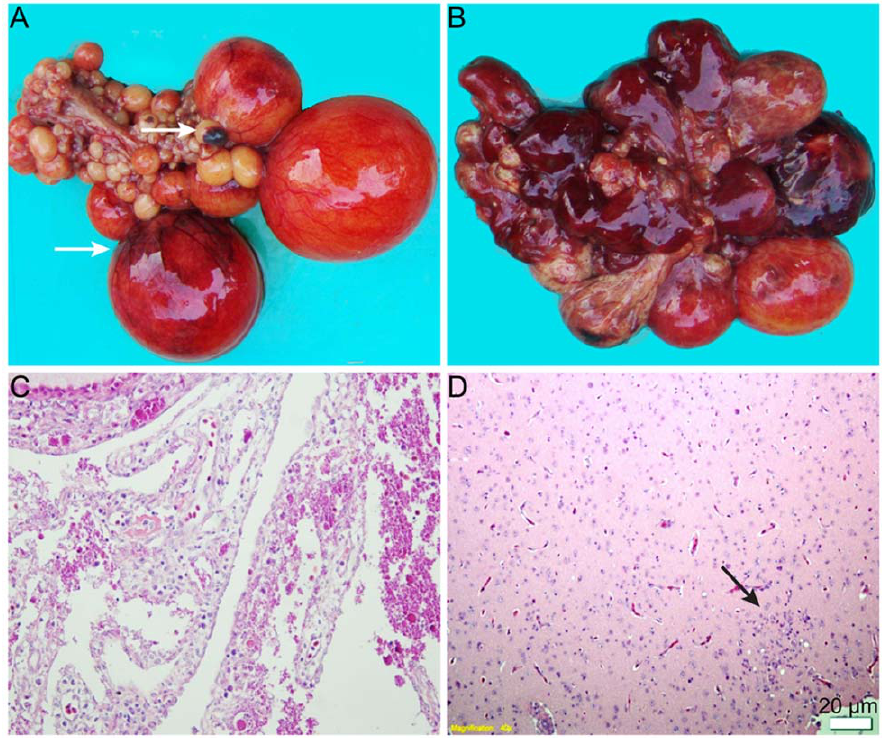
Figure 3. Gross lesions and histopathology of the clinical samples. Mild hemorrhage of ovarian follicles (arrow) in the early stage of infection (A); Severe hamorrhage and regression of ovarian follicles (B); HE stained ovary section, the follicles ruptured and filled with round or granular eosinophilic bodies (C). HE-stained brain section showing focal gliosis (arrow) (D).